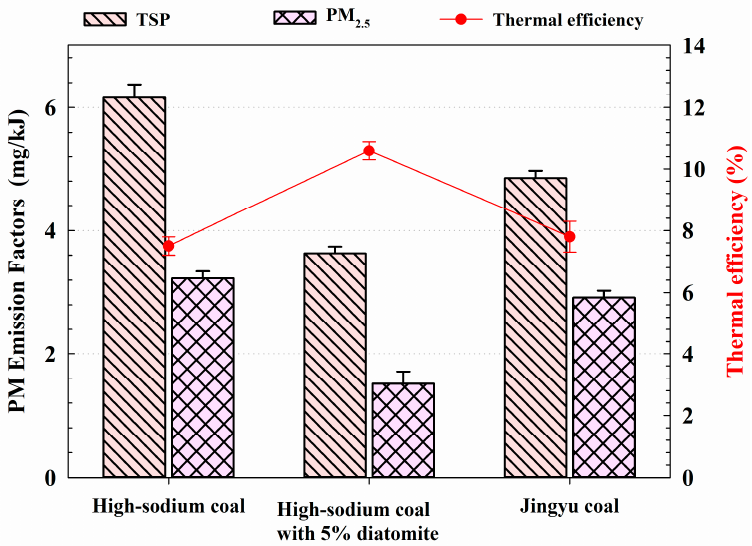
Figure 2. EFs for TSP and PM 2.5 , and TE for the tested coal samples.